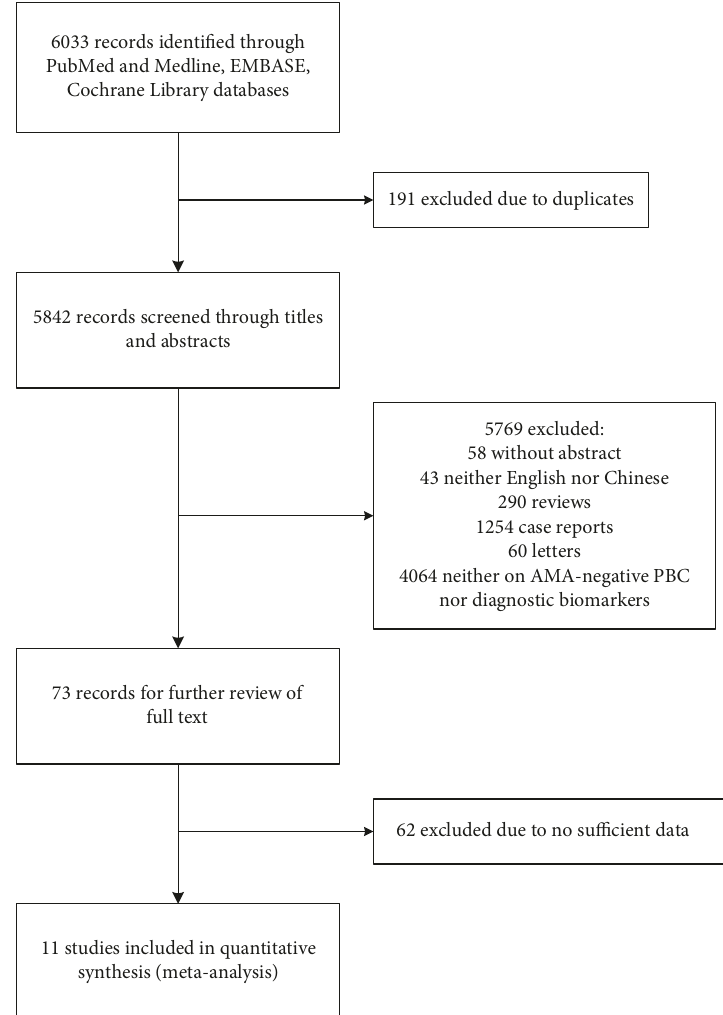
Figure 1: Flowchart of studies included in the meta-analysis. 5842 articles without duplicates were enrolled during database searching. Finally, 11 studies were included in quantitative synthesis and meta-analysis with the following inclusion criteria: (i) assessed the diagnostic accuracy of the ANA test on AMA-negative PBC patients and controls; (ii) full-text articles; (iii) showed su ffi cient information of true positive (TP), false positive (FP), false negative (FN), and true negative (TN) numbers to calculate sensitivity and speci fi city; and (iv) the publication language should be in either English or Chinese. The exclusion criteria were as follows: (i) review articles, case reports, and letters; (ii) lack of su ffi cient data; and (iii) articles without an abstract. Abbreviations: AMA: antimitochondrial antibody; PBC: primary biliary